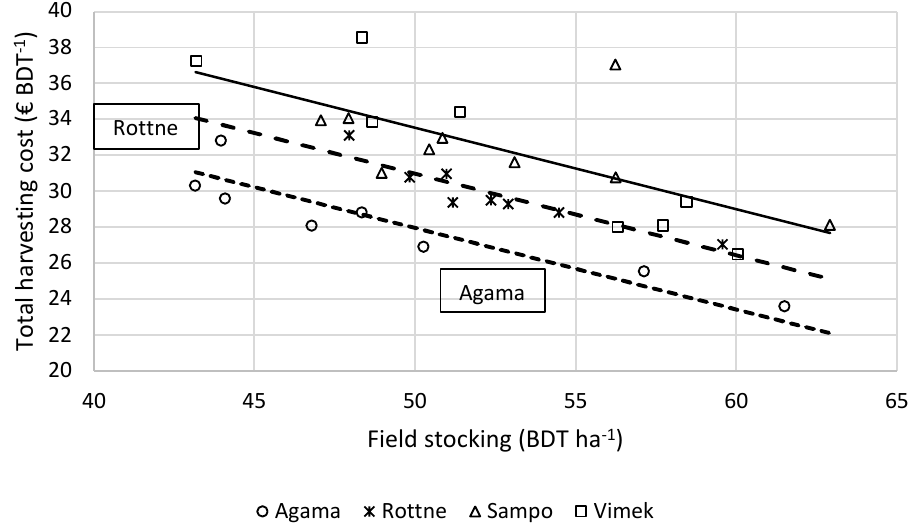
Figure 3. Total harvesting cost as a function of field stocking and harvesting chain: point scatter and regression graphs.